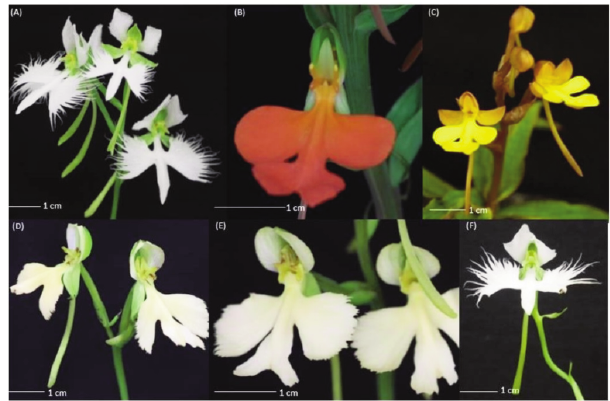
Fig. 6 ­ Floral morphology of the parents and hybrids. (A) HRA,